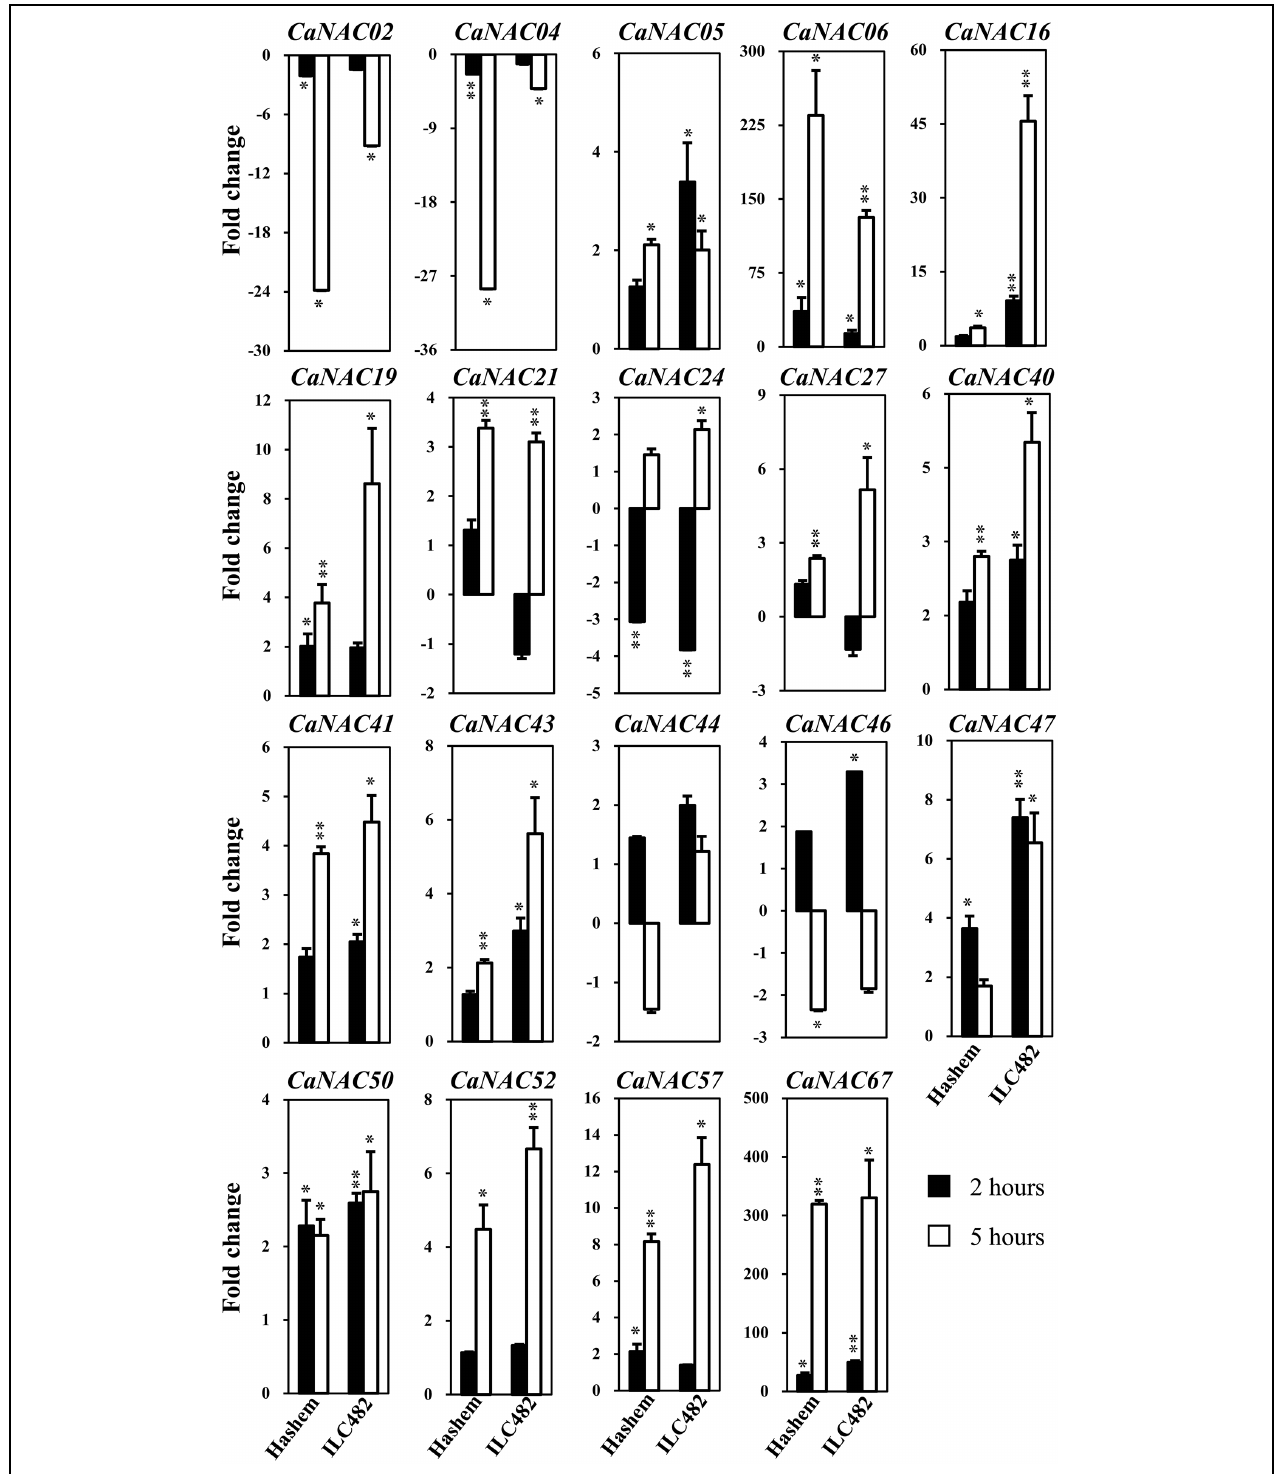
FIGURE 2 | Expression of 19 selected CaNAC genes in leaves of drought-tolerantILC482 and drought-sensitive Hashem cultivars under dehydration. Expression data of the CaNAC genes in ILC482 leaves were obtained by RT-qPCR of leaf samples treated with well-water control or dehydration for 2 or 5 h. For convenient comparison, expression data of the